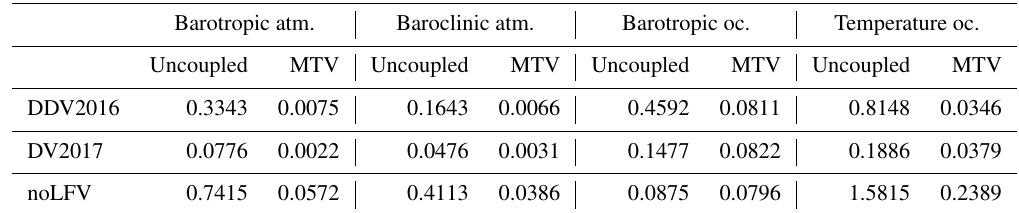
Table 2. Component averaged Kullback–Leibler divergence with respect to the distributions of the full coupled system, in the case of